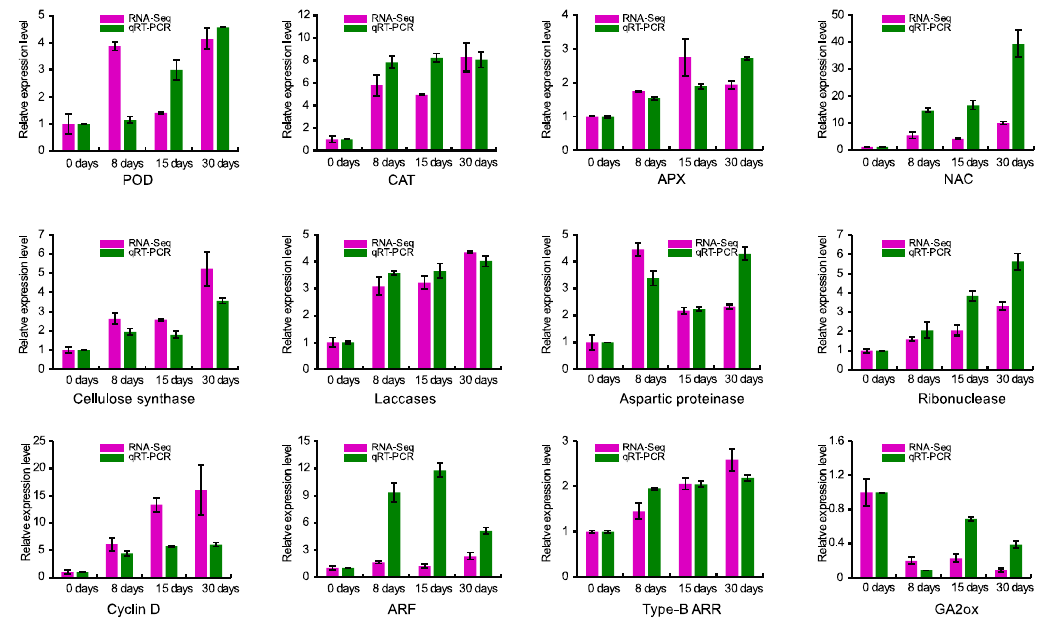
Figure 9. Validation RNA-seq data by real-time quantitative RT-PCR. The expression levels at 0 days are considered as 1.